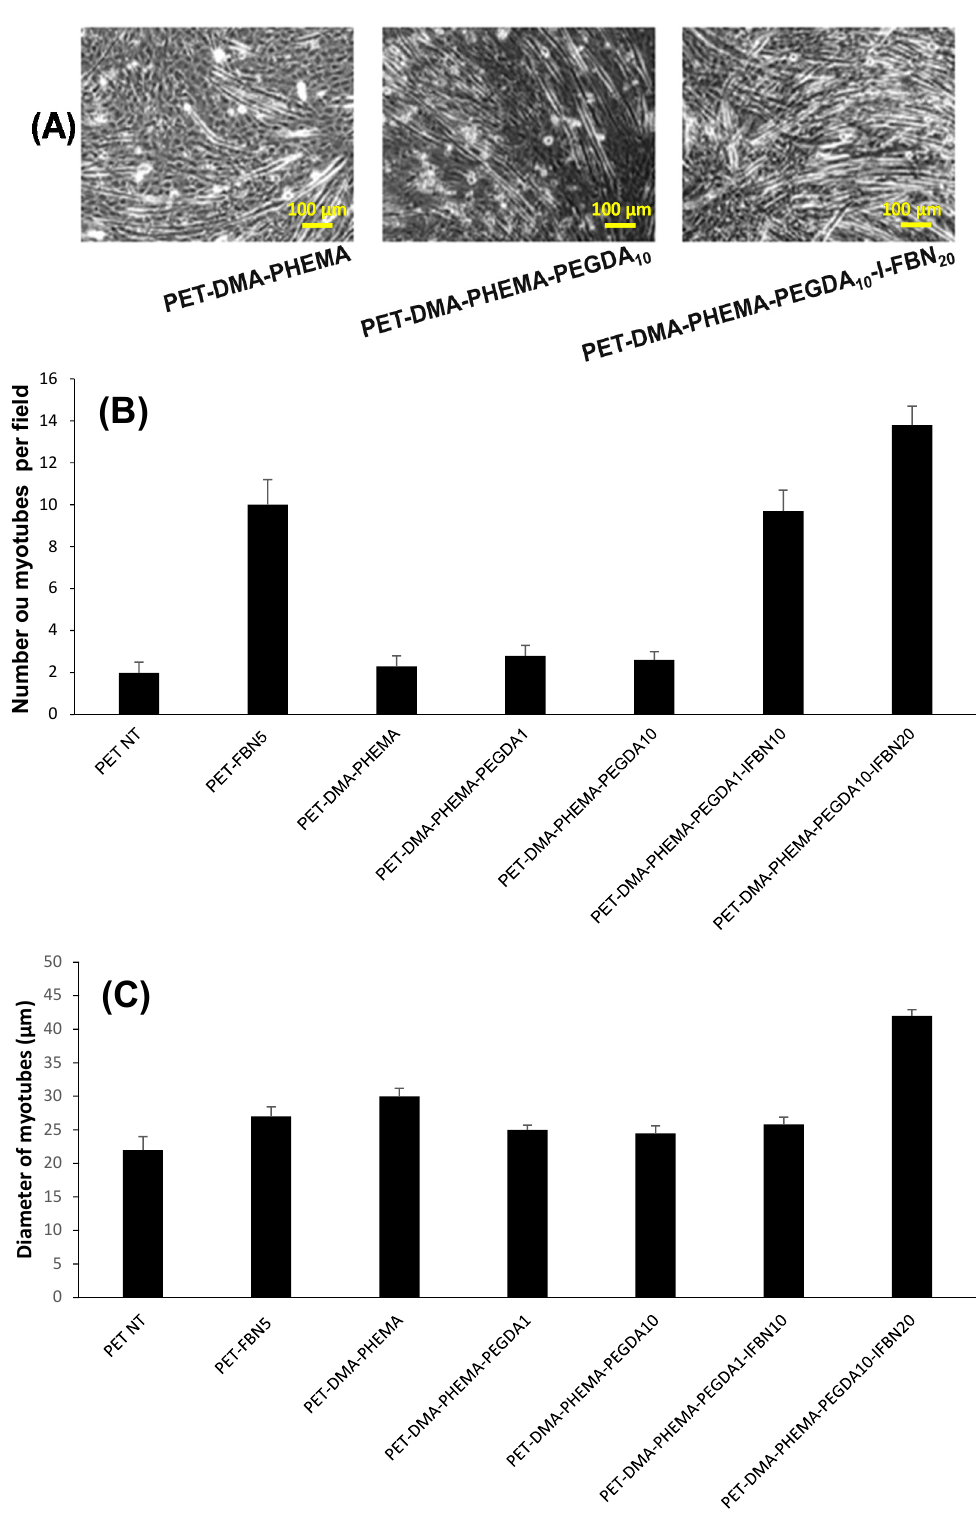
Figure 7. Cell differentiation on PET membranes treated with PEGDA. C2C12 muscular cells were plated at day 0 at the same conditions as for Figure 5. They were left 7 days to grow and differentiate. At day 7, the medium was changed from growth medium to differentiation medium. ( A ) Photomicrographs showing myotubes, the long fusiform multinucleated cells resulting from fusion of individual myoblastic cells, taken 7 days after plating. In the figure, myotubes differentiated on PET-DMA-PHEMA, PET-DMA-PHEMA-PEGDA 10 control membranes, and processed completely with PET-DMA-PHEMA-PEGDA 10 -I-FBN 20 surfaces, are shown. ( B ) At day 8, the number of myotubes on PET membranes was counted on 5